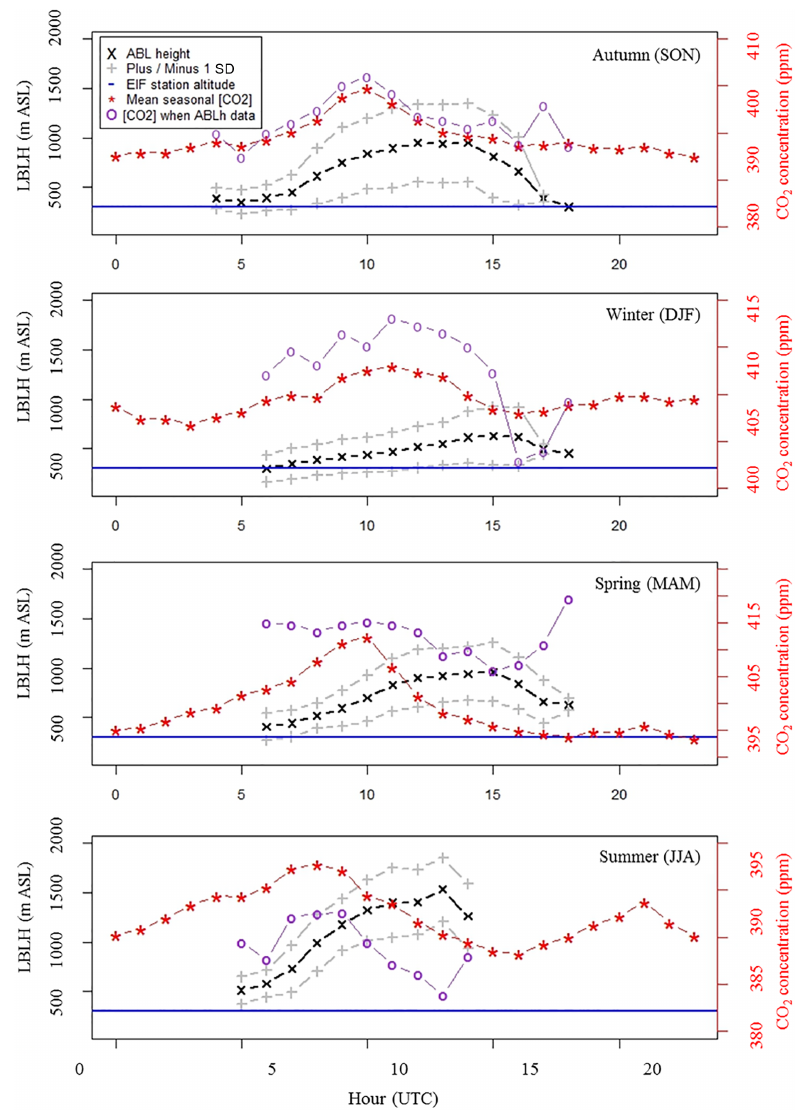
Figure 6. Diurnal cycles of the hourly LBLH estimate means (in black) ± 1 σ standard deviation (in grey) and of the CO 2 hourly means (in red) observed by season at QUALAIR (urban site, 25ma.g.l.) and EIF (urban site, 317ma.g.l.), respectively. Time is in UTC. The blue horizontal line is the elevation of EIF. The violet circles give the CO 2 concentration (according to the red scale) at the same moments when the LBLH (in black) was